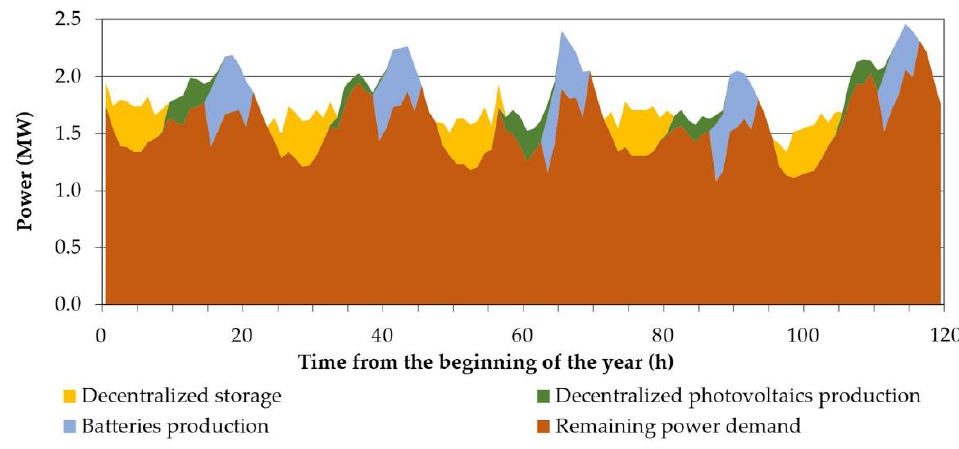
Figure 18. Peak demand shaving on Sifnos with decentralized electricity production and storage.